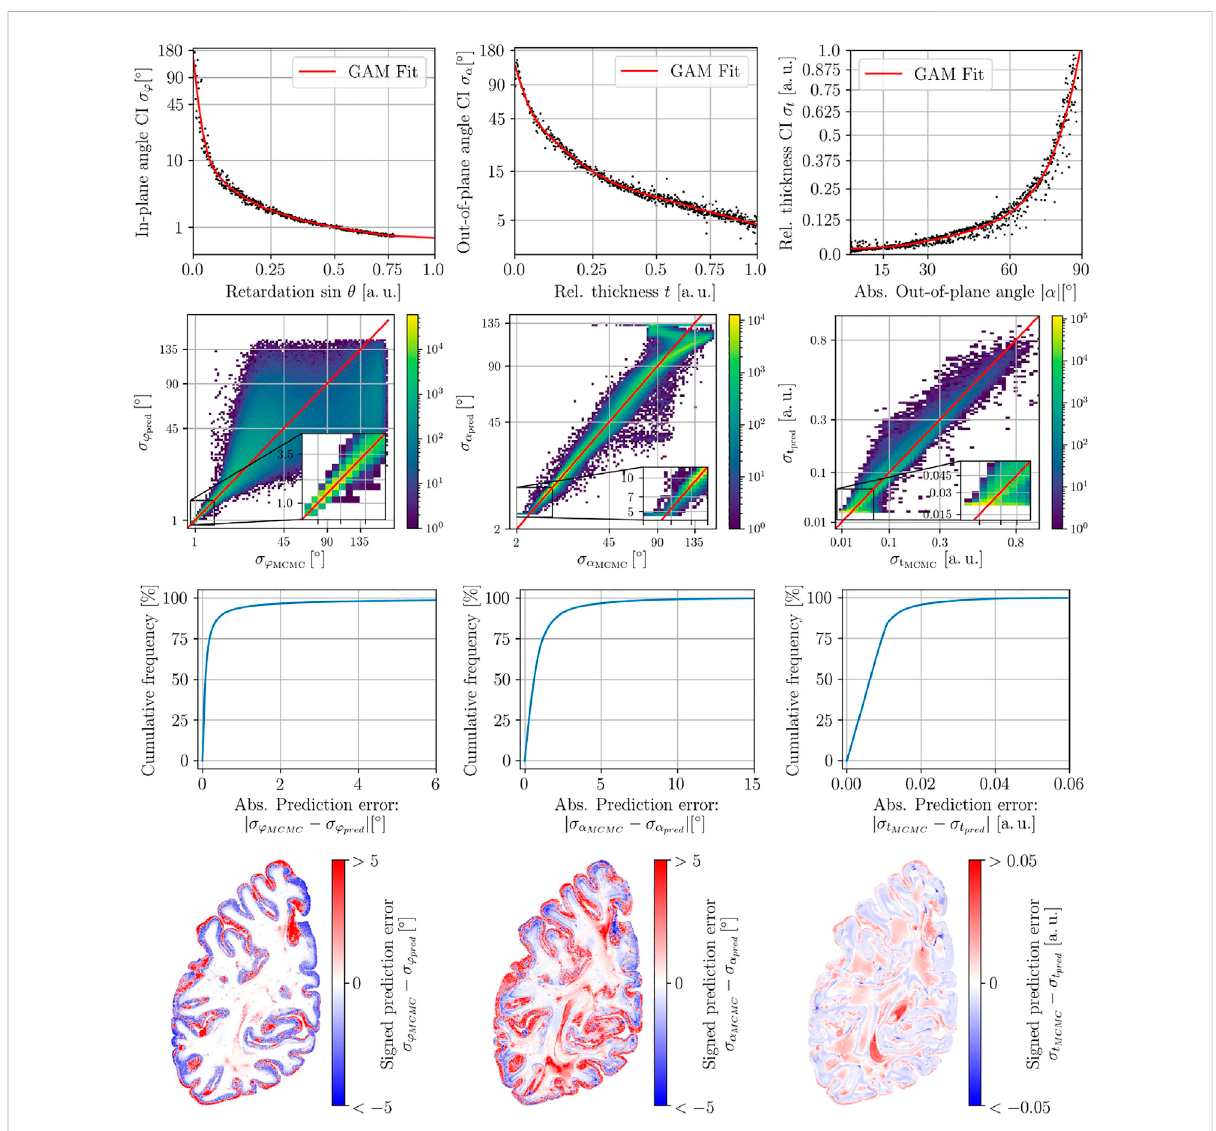
FIGURE 8 Collected evaluation of the three uncertainty predictions for one selected section with N = 800 samples. Left column: In-plane angle uncertainty. Central Column: Out-of-plane angle uncertainty. Right Column: relative thickness uncertainty. From top to bottom: 1.Training samples and fi tted GAM model. 2. Prediction vs Ground truth (MCMC sampling). 3. Cumulative Histogram of the absolute prediction error within the white matter. 4. Maps of the signed prediction